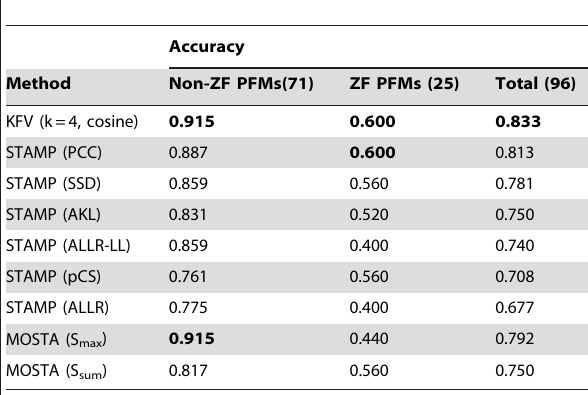
Table 3. Comparison of the KFV algorithm with other methods for motif retrieval using